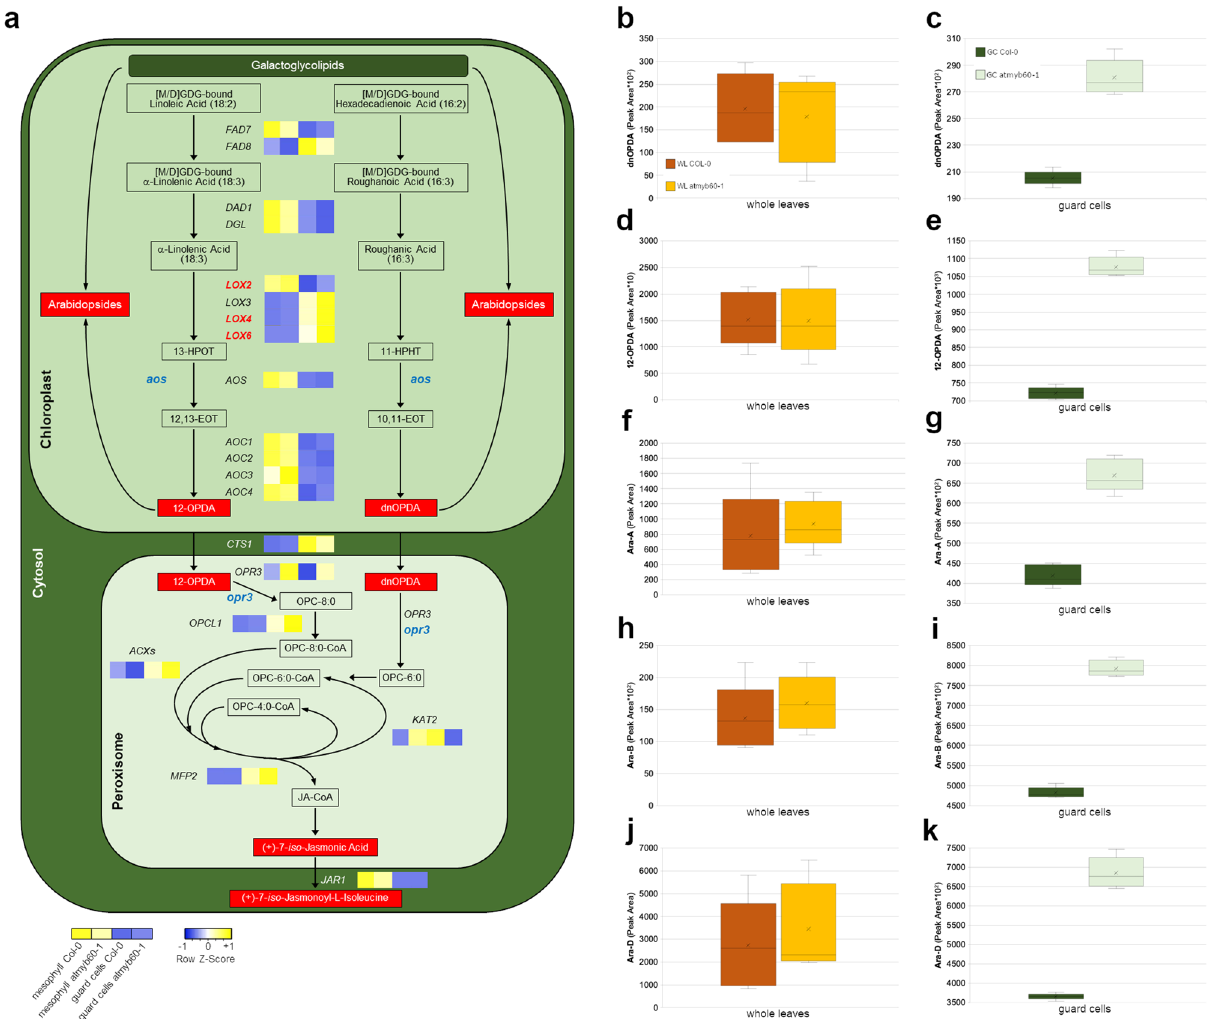
Figure 2. Accumulation of free and esterified 12-OPDA and dnOPDA is enhanced in guard cells from the atmyb60-1 mutant. ( a ) Schematic representation of the JA biosynthetic pathway. Red boxes represent metabolites identified as over-accumulated in the atmyb60-1 mutant compared with the wild type. Genes coding for JA biosynthetic enzymes are indicated by their acronyms (uppercase, italics). Heatmaps indicate relative gene expression in LM-purified Col-0 or atmyb60-1 mesophyll and guard cells (Heatmapper, http:// www. heatm apper. ca). Genes upregulated in the mutant as compared with the wild type are highlighted in red ( 13-LOXs ). Mutant alleles employed in the study are highlighted in blue (lowercase, italics). Modified from Acosta and Farmer (2010) 4 . Abbreviations:[M/D]GDG, mono- or di-galactosyldiacylglycerol; 13-HPOT, 13(S)-hydroperoxy- octadecatrienoic acid; 12,13-EOT, (13S)-12,13-epoxy-octadecatrienoic acid; OPC-8:0, 3-oxo-2(2 ′ -pentenyl)- cyclopentane-1-octanoic acid; OPC-6:0, 3-oxo-2(2 ′ -pentenyl)-cyclopentane-1-hexanoic acid; OPC4:0, 3-oxo- 2(2 ’- pentenyl)-cyclopentane-1-butanoic acid; CoA, Coenzyme A. ( b – k ), relative amounts of free dnOPDA ( b , c ), free 12-OPDA ( d , e ), Ara-A ( f , g ), Ara-B ( h , i ) and Ara-D ( j , k ), in whole leaves or epidermal fractions enriched in guard cells obtained from wild type or atmyb60-1 plants. Note the different scale of the Y-axis between whole leaves and guard cells. "a" indicates significant differences between wild type and atmyb60-1 samples (P < 0.01, t